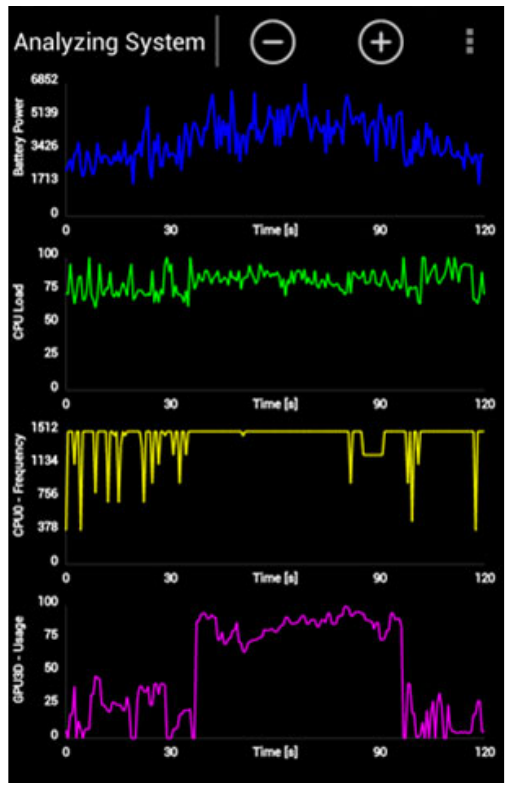
Figure 8. Trepn profiling tool